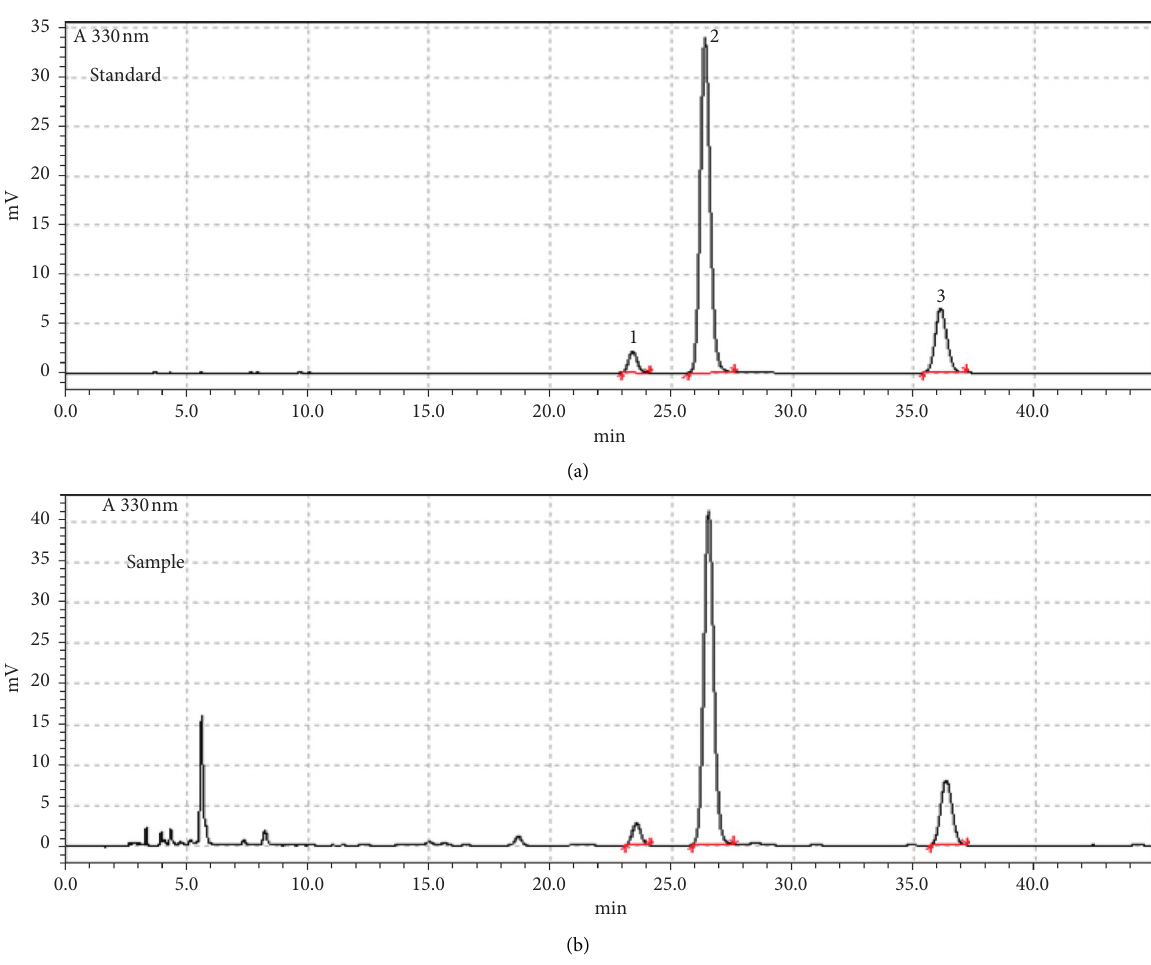
Figure 1: HPLC chromatogram: (a) standard and (b) sample (Peak 1: 3,4-CQA, Peak 2: 3,5-CQA, and Peak 3: 4,5-CQA). Table 1: Raw material samples: geographical origin and acquisition